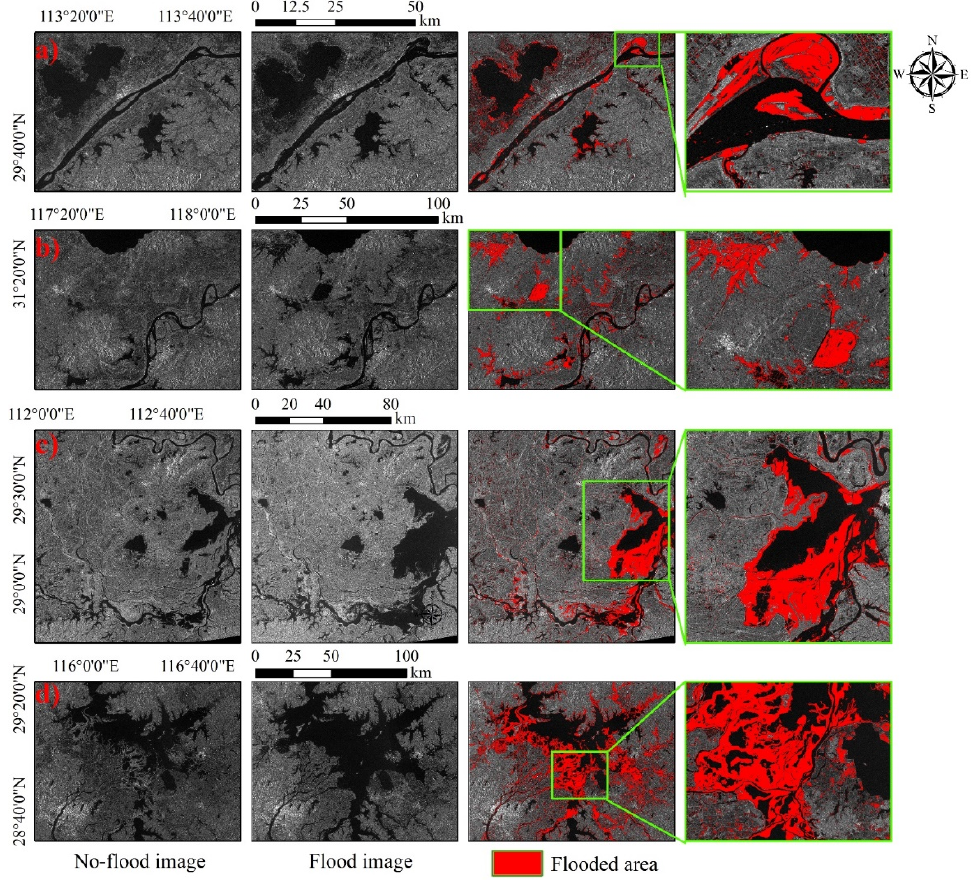
Figure 9. Near-real-time flood detection results obtained with Sentinel-1 SAR images by using deep learning model of UNet. ( a ) Flood detected in Honghu Lake in 2020. ( b ) Flood detected in Chaohu Lake basin in 2020. ( c ) Flood detected in Dongting Lake in 2017. ( d ) Flood detected in Poyang Lake in 2020.